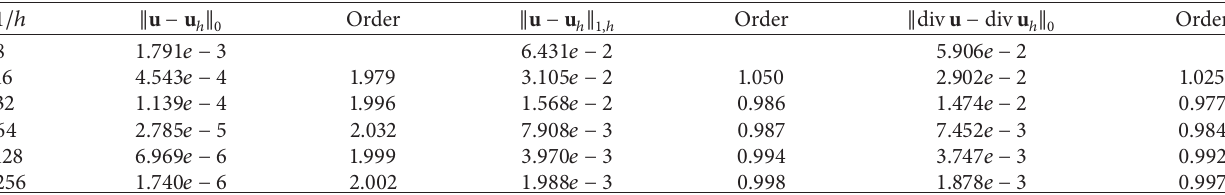
Table 5: 𝜇 − = 1 , 𝜇 + = 10 , 𝜆 = 5 𝜇 , and elliptical interface.